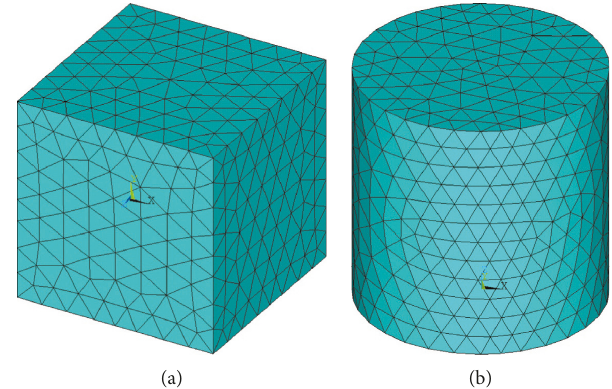
Figure 3: Finite element models of rocks.